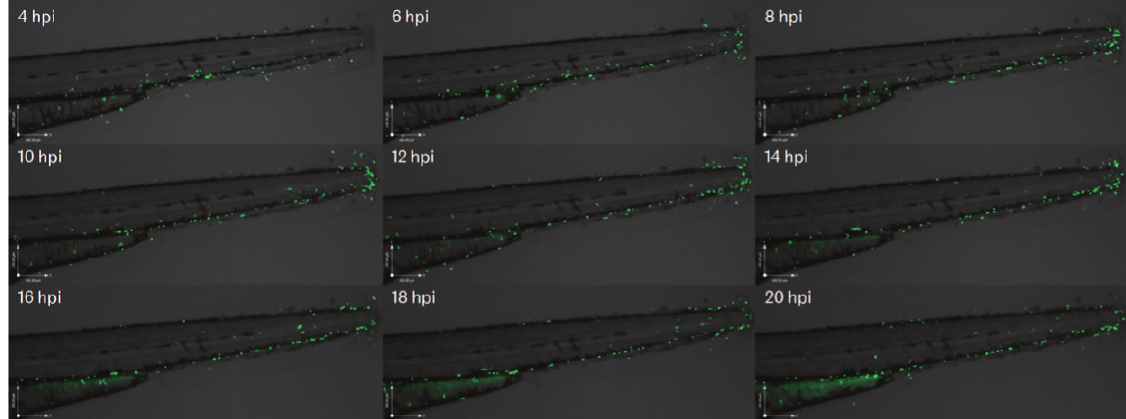
Figure 2: At peak inflammation, new neutrophils are recruited to the site of injury. Photomontage generated from the time-lapse data used in Figure 1(b), and Supplemental Movie 1, imaged using the GFP filterset, showing neutrophil recruitment to the site of injury over the same timespan. Green neutrophils can be seen to accumulate at the site of injury between 6 and 14 hours after injury.